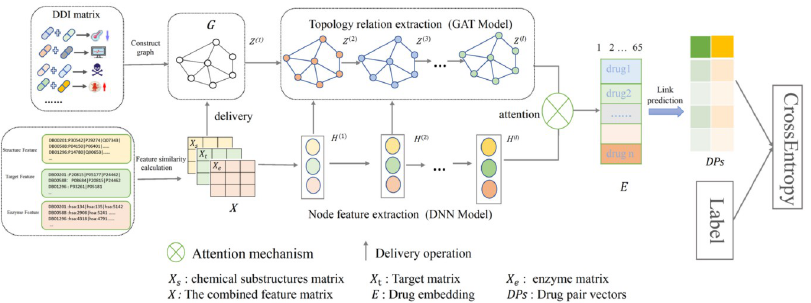
Fig 1. Overall framework of the proposed model. The changes in the node colors indicate the process of node learning, and H ( l ) and Z ( l ) indicate the vector representations learned at the l model,